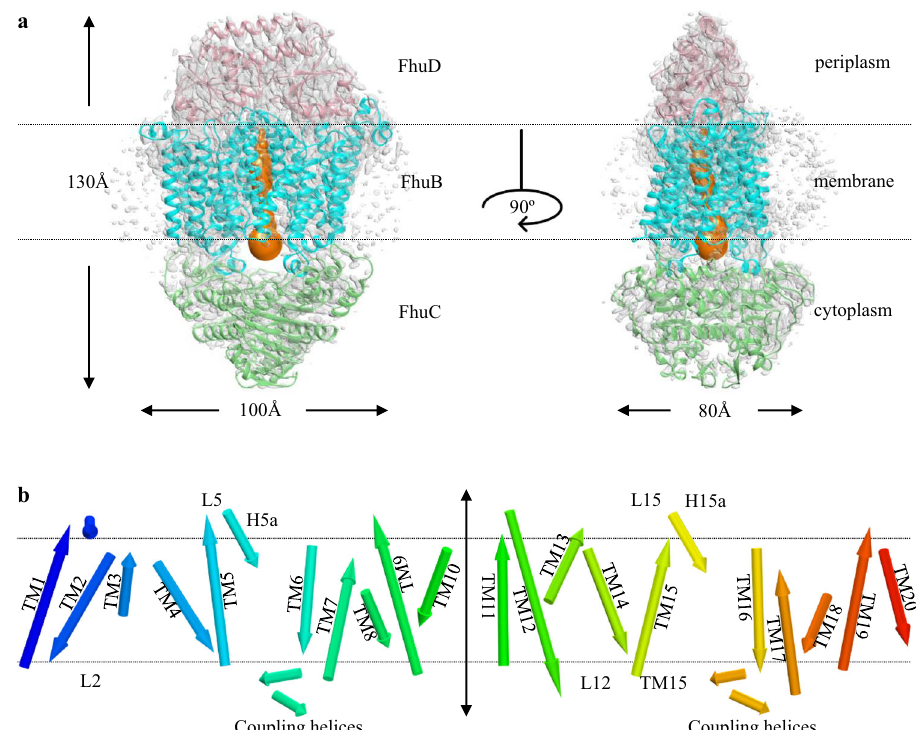
Fig. 2 Overall structure of FhuCDB. a Atomic model of FhuCDB fi ts in the cryo-EM density (gray). FhuD in pink, FhuB in cyan, and two FhuC in green. The calculated tunnel in FhuB (orange) indicates that the complex is in the inward-open conformation. b Topology of FhuB showing 20 TMs colored in rainbow with N-terminal in blue and C-terminal in red. Important helices and loops discussed in this article, as well as all TMs are